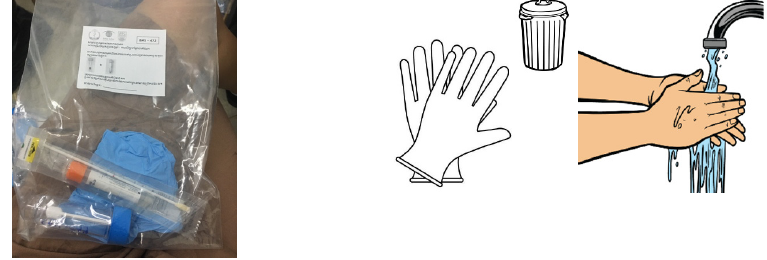
Figure 2. Participant stool collection infographic (English translation).